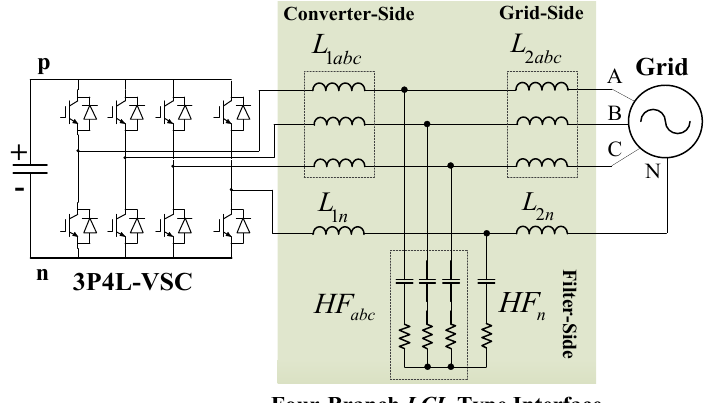
Figure 2. 3P4L-APF with the proposed 4B-LCL